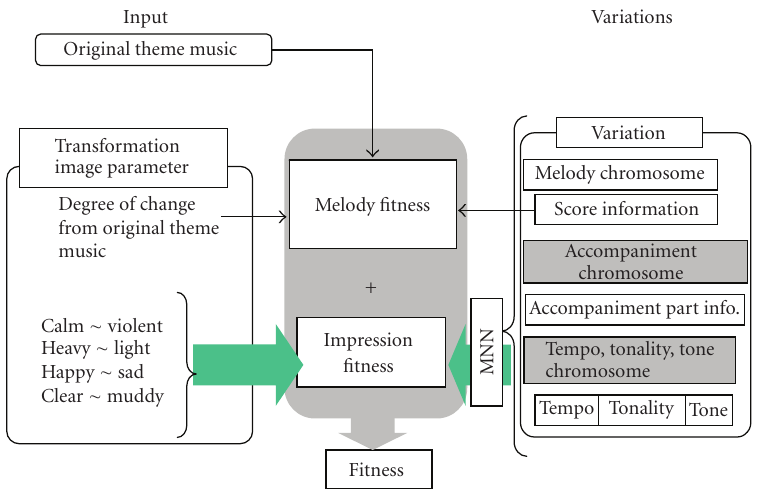
Figure 4: Calculation of fitness